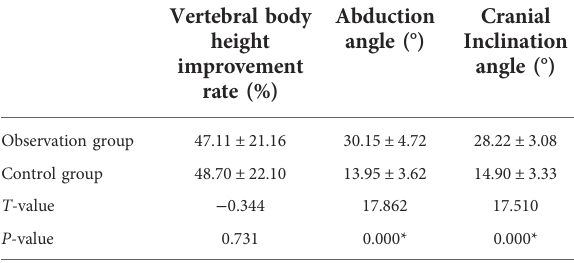
TABLE 2 Rate of improvement in vertebral body height, abduction angle, and cranial inclination angle ( x